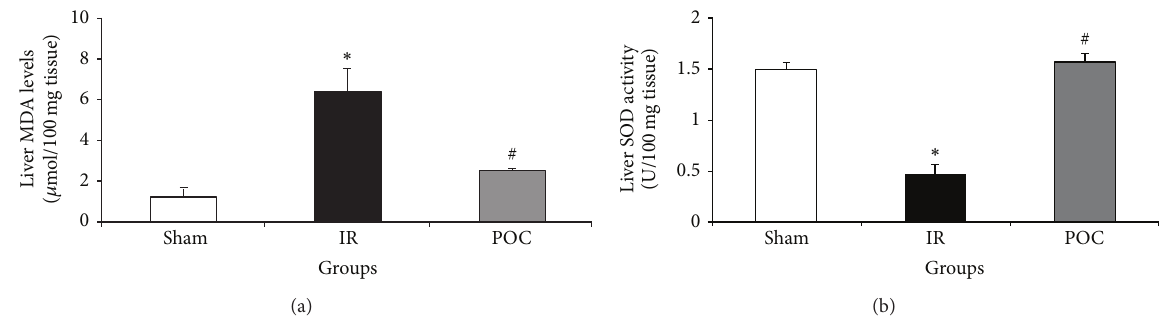
Figure 2: Changes in liver MDA levels (a) and SOD activity (b) in different groups. The data are presented as mean ± SEM. ∗ 𝑃 < 0.05 versus sham group. # 𝑃 < 0.05 versus IR group. IR: 45min renal ischemia followed by 24 hours of reperfusion. POC group: 4 cycles of 10 seconds of intermittent IR just at the beginning of reperfusion in the